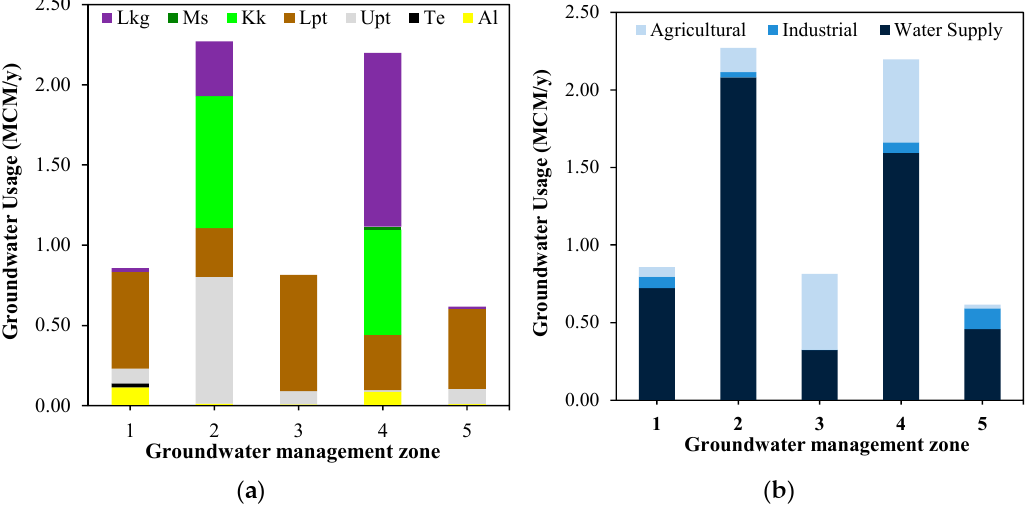
Figure 8. Comparison of groundwater usages and groundwater management zones for ( a ) hydrostratigraphic units and ( b ) types of groundwater usage.